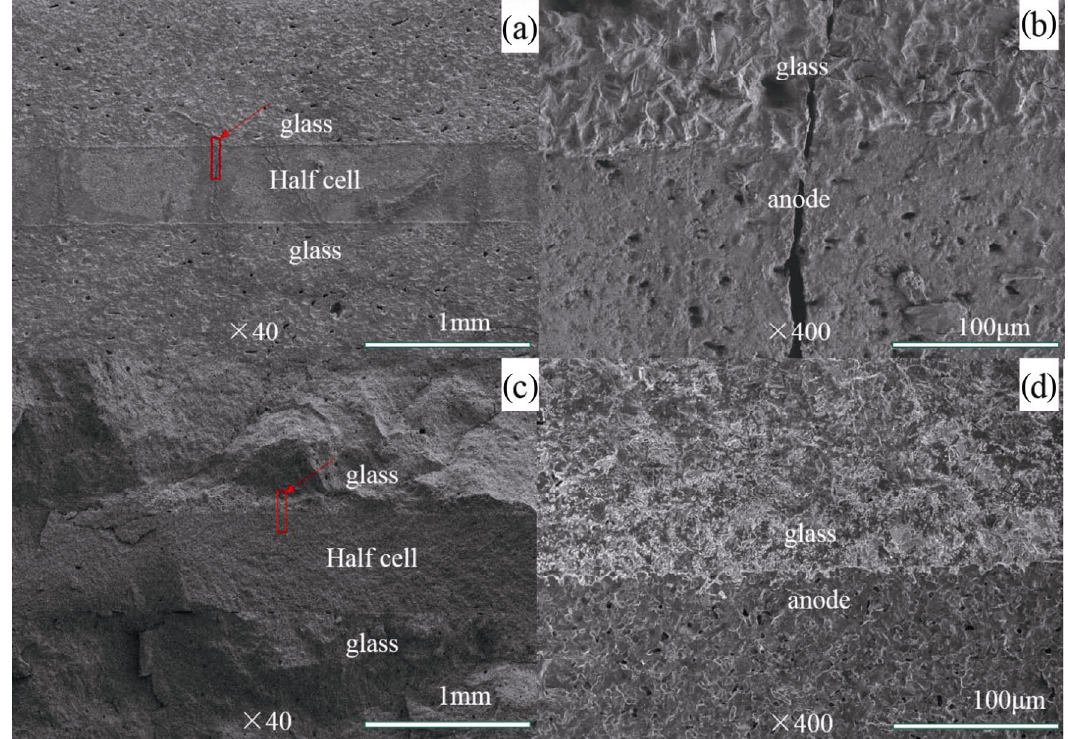
Fig. 8 Cross-sectional SEM images of sealing interface between glass and half-cell after the heat treatment at 1123 K for 30 min, followed by soaking at 1023 K for 100 h: (a) A glass/half-cell/A glass at 40× magnification; (b) A glass/anode at 400× magnification; (c) B glass/half-cell/B glass at 40× magnification; (d) B glass/anode at 400×